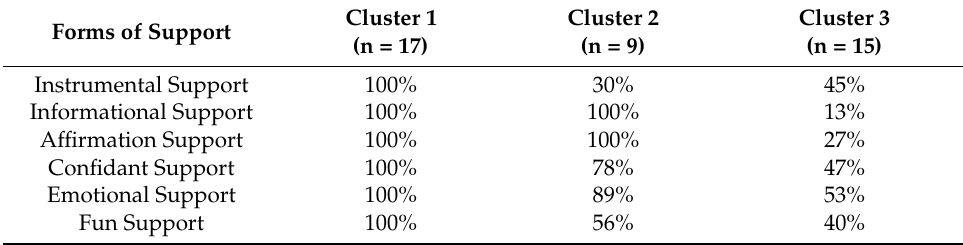
Table 2. Clusters of social support in relationships of individuals with chronic